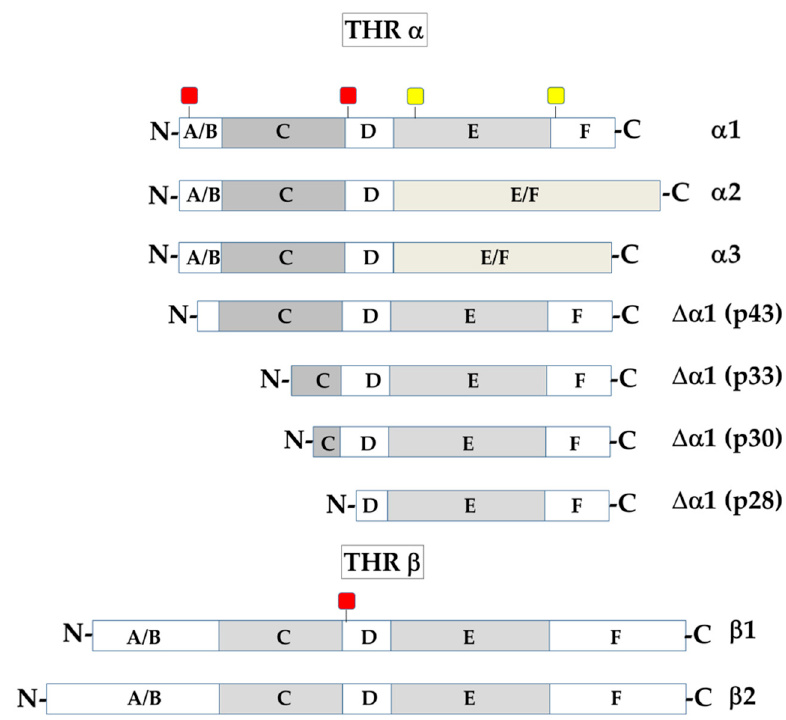
Figure 1. Schematic representation of the domain structure of THR α and THR β . The full-length TH receptors contain: (i) an N-terminal A/B domain, involved in transcription transactivation; (ii) a DNA-binding domain (C), which recognizes and binds the TH-response elements (TREs), and is also involved in receptor dimerization; (iii) a hinge domain (D) and (iv) an E/F domain that can be involved in binding the hormone, as well as in protein–protein interactions. The full-length THR α 1 contains two nuclear localization signals (NLS: red squares) and two atypical mitochondrial import sequences (MIS: yellow squares). The THR α 1 shorter forms, which derive from internal AUG translational usage, lack one or both NLS; in these proteins, the localizing effect of the mitochondrial signals is prevalent. THR β contains only one NLS (red square) in the D domain